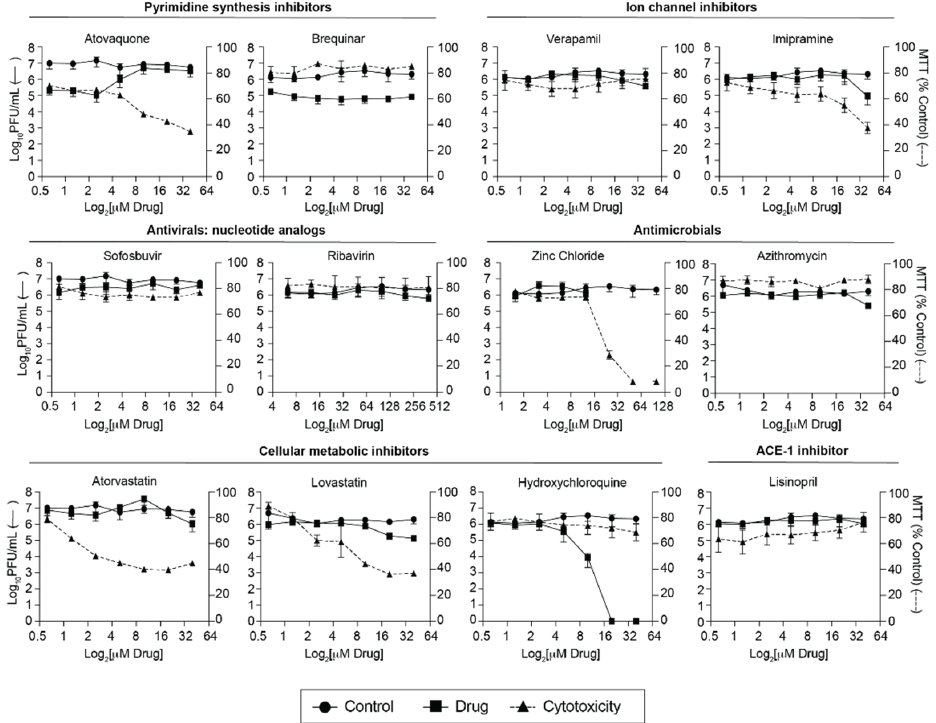
Figure 1. Screen of FDA-approved compounds against SARS-CoV-2 on Vero E6 cells. Vero E6 cells were pretreated for 2 h with increasing concentrations of the indicated drug or vehicle control and then infected with SARS-CoV-2 at an MOI of 0.1 At 36 h post infection (hpi), supernatants were collected, and infectious particles were quantified by plaque assay on Vero E6 cells. For MTT assays, Vero E6 cells were treated with compound or vehicle for 36 h and harvested for analysis. Data represents the mean and range of two independent experiments performed in technical duplicates.